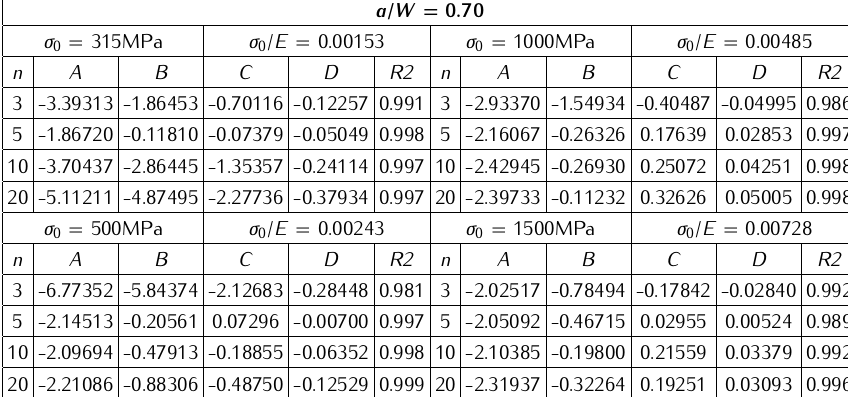
Table 7. The coefficients of equation (13) for CC(T) specimen with the crack length a / W =0.70.